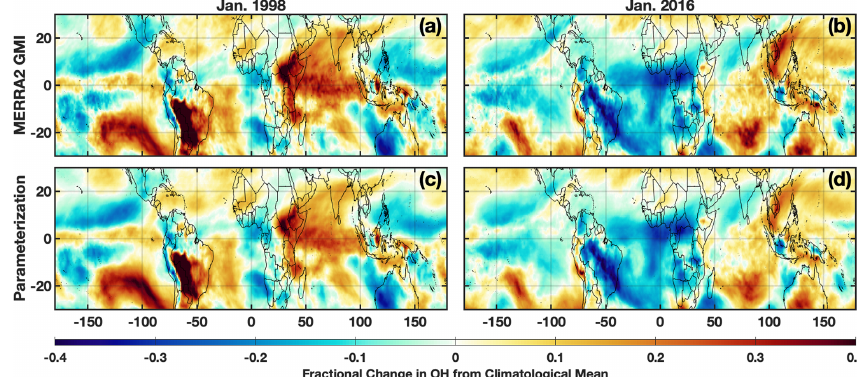
Figure 9. Fractional difference in the indicated variable between January 1998 (a, c) and the climatological mean (1980–2019) calculated from the MERRA2 GMI simulation averaged over the MFT. The same values but for January 2016 are indicated on the right. Species shown are OH from the MERRA2 GMI simulation (a, b) and OH calculated by the parameterization (c, d)